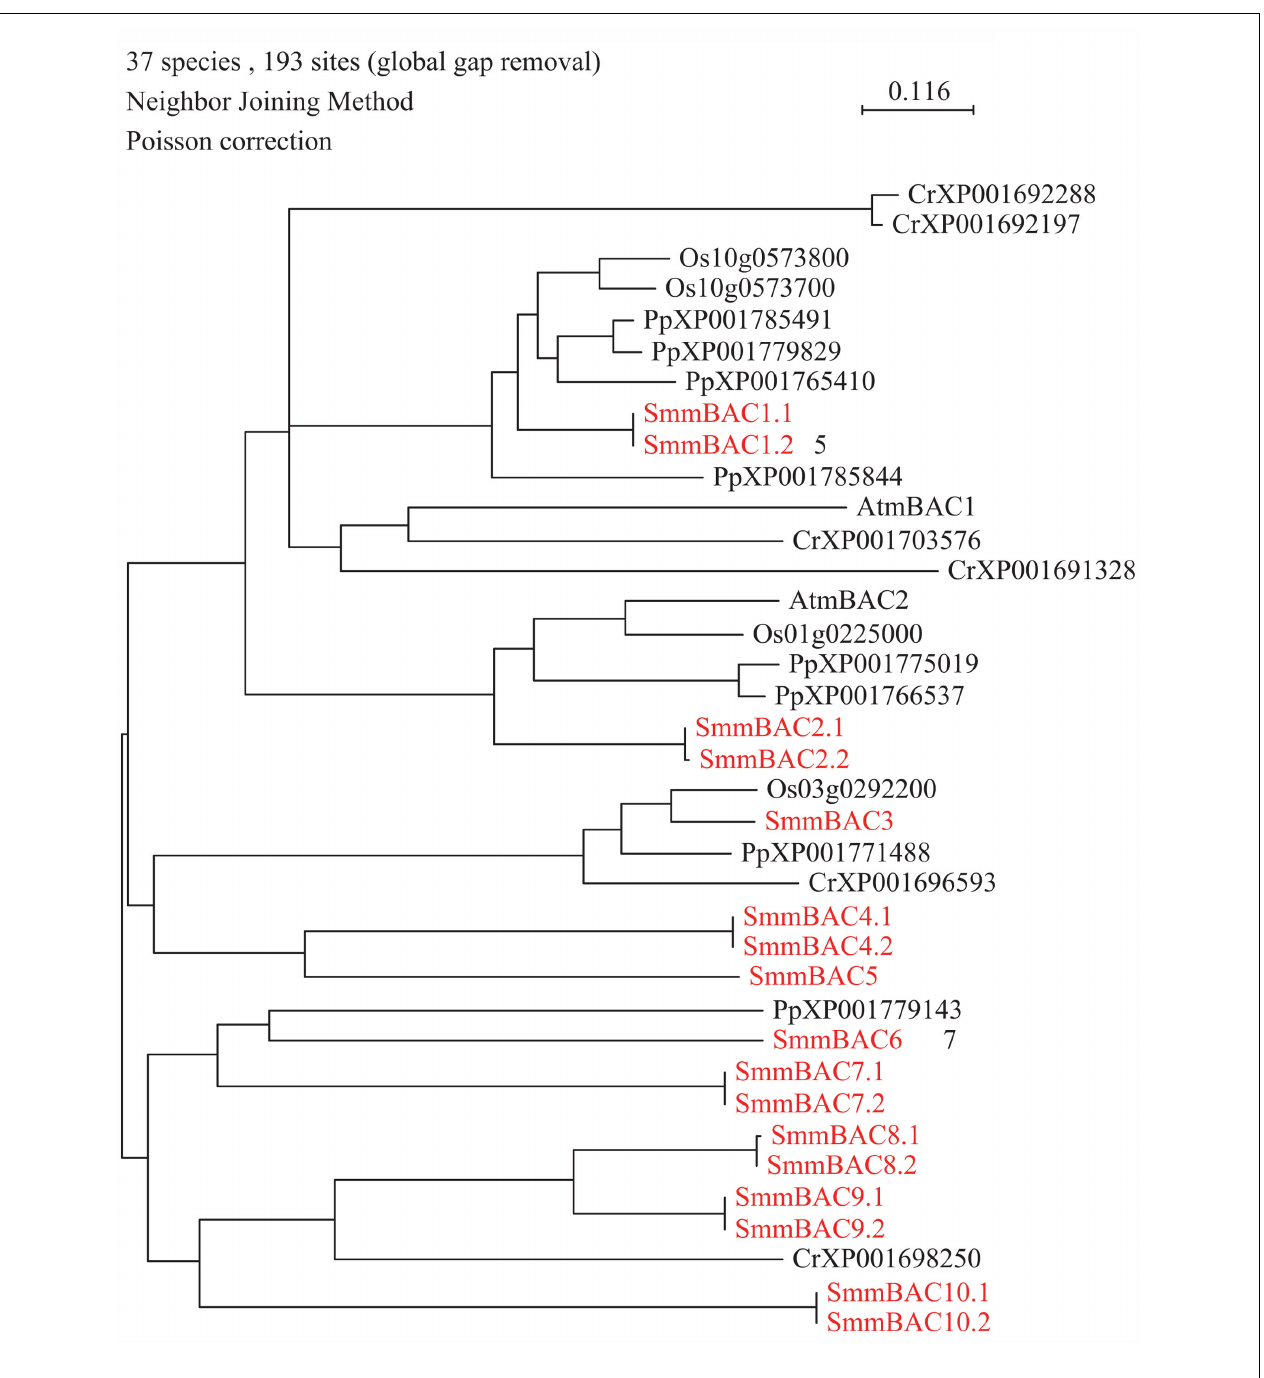
Chlamydomonas reinhardtii ; Os, Oryza sativa ; Pp, Physcomitrella patens ; Sm, Selaginella moellendorffii. Red letters indicate a Selaginella moellendorffii